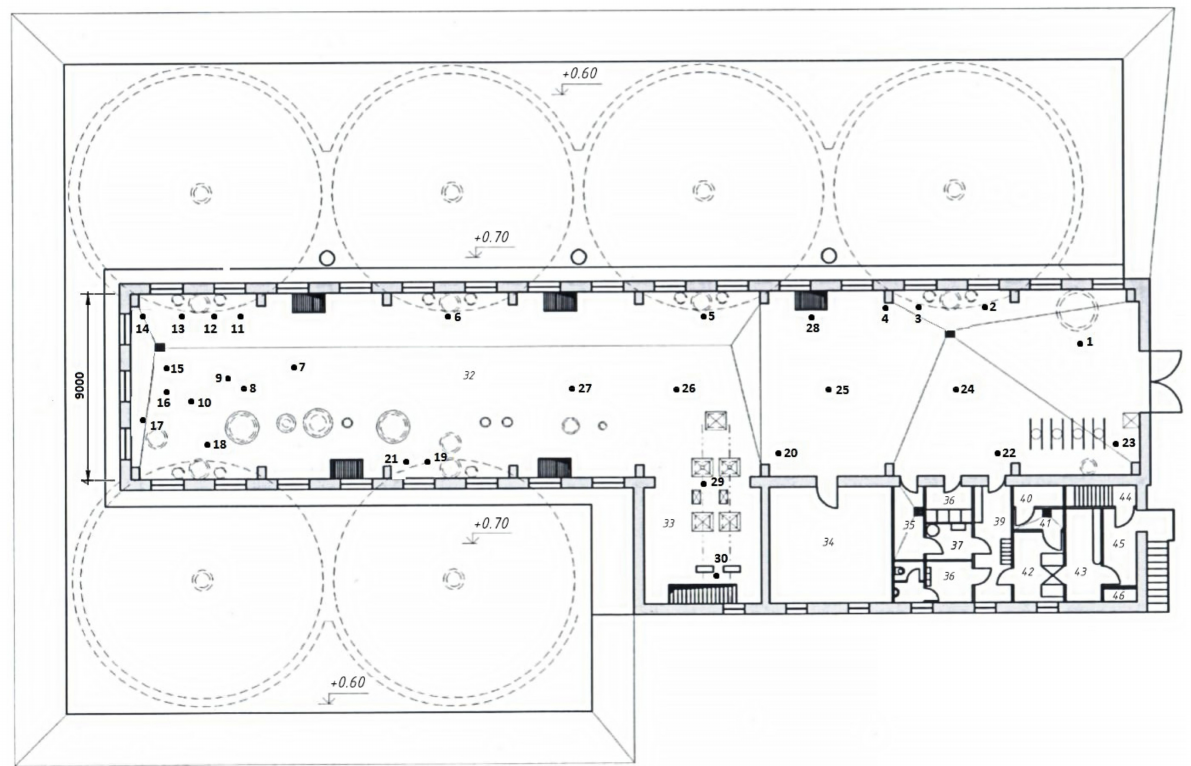
Figure 7. Cartogram of the premises of the control room for No. 2 at elevation